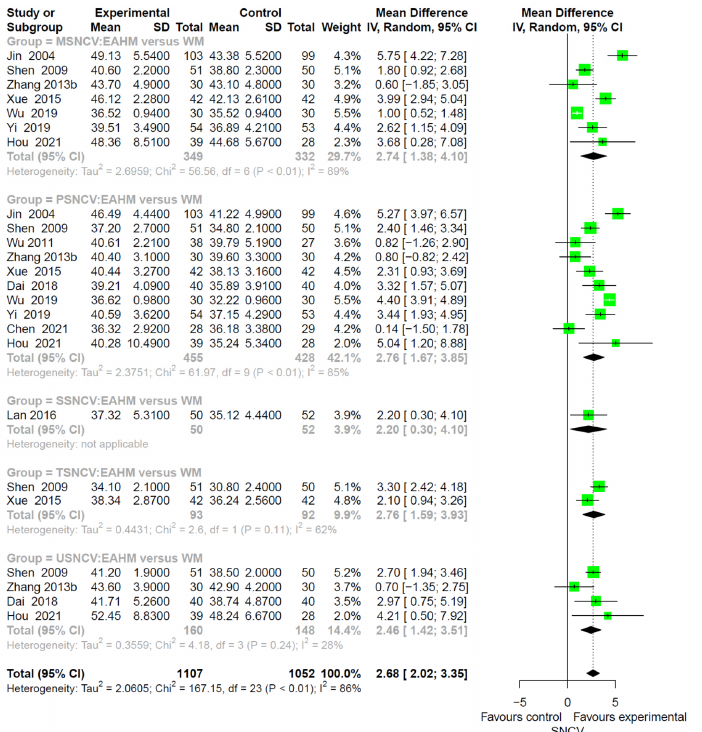
Figure 3. Forest plot of the trials reporting the effect of East Asian herbal medicine monotherapy on sensory nerve conduction velocity for peripheral neuropathy. In the 21 studies comparing the effect of combined EAHM and WM therapy with the WM monotherapy control, the combined therapy significantly improved SNCV than the WM monotherapy control ( n = 4454; MD 3.06, 95% CI 2.56–3.56, p < 0.0001; heterogeneity chi-square = 317.64, df = 43, p < 0.01; I 2 = 86%; Figure 4).